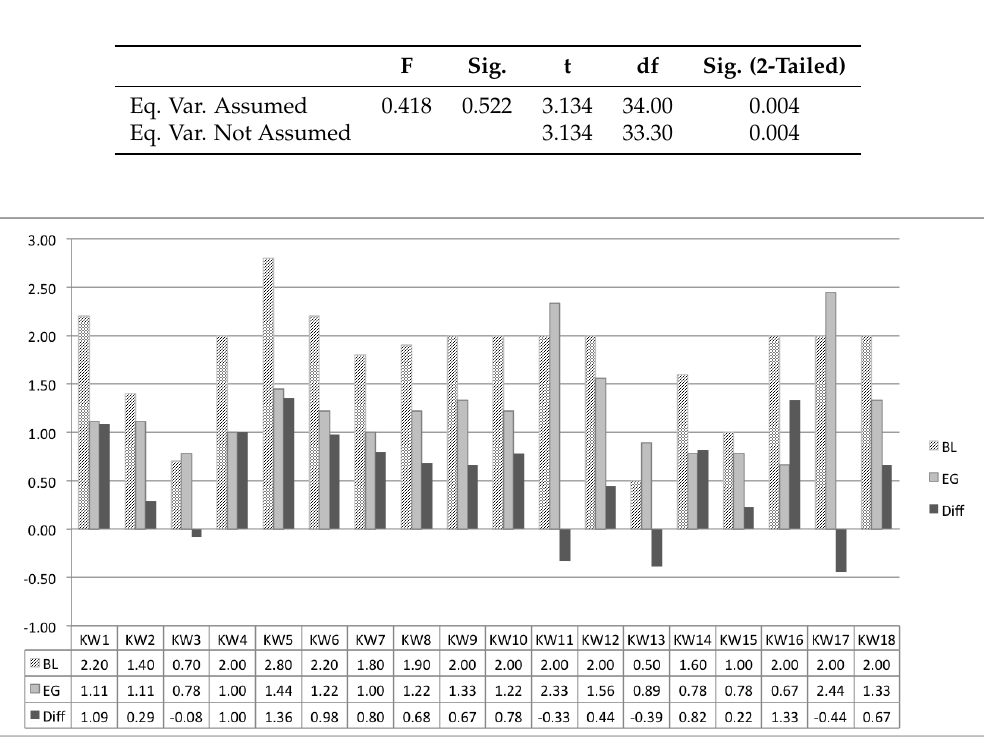
Table 3. Independent Samples Tests for Knowledge intake. The first two columns are the Levene’s Test for Equality of Variances, showing a significance greater than 0.05 (Sig). The other three columns are